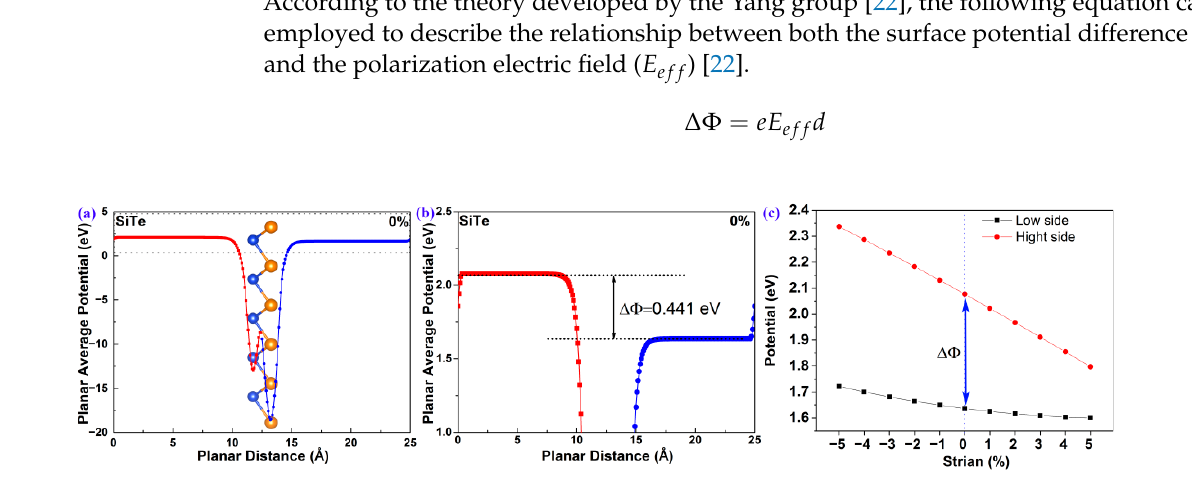
Figure 4. ( a ) The planar average potential of 2D polar monolayer SiTe; ( b ) an enlarged section of ( a ); ( c ) the surface potential di ff erence ( ΔΦ ) of 2D polar monolayer SiTe at di ff erent strains. ( c ) the surface potential difference ( ∆Φ ) of 2D polar monolayer SiTe at different The larger ΔΦ , the larger